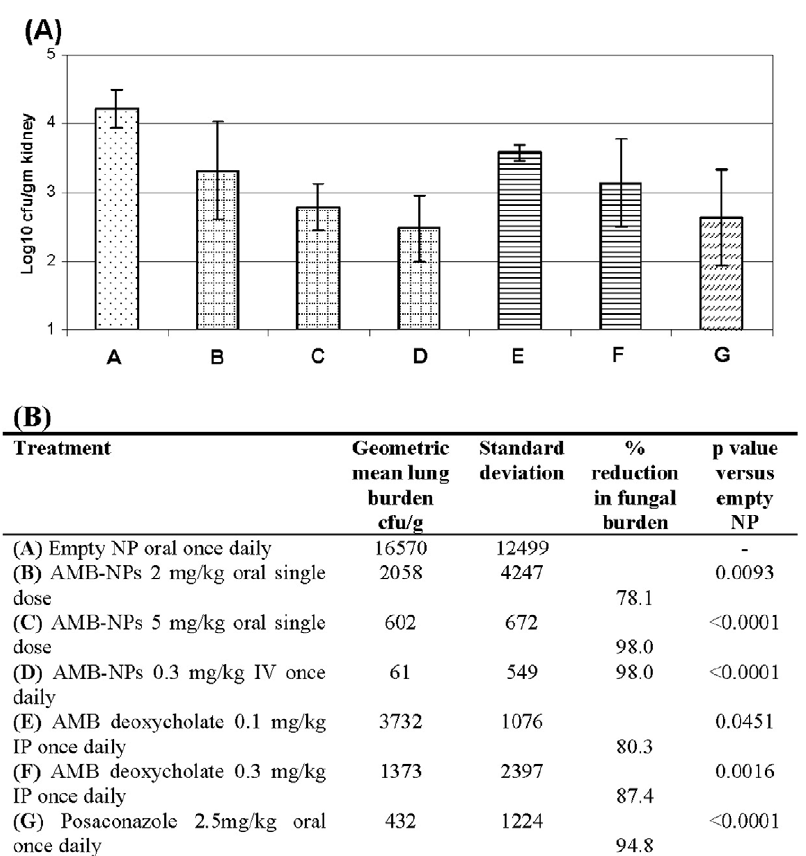
Figure 6. Kidney burden of mice with disseminated aspergillosis treated with AMB-NPs, AMB deoxycholate, and Posaconazole 101 hours post infection (Panel A). Geometric mean tissue burdens (and standard deviations) of mice with disseminated aspergillosis treated with AMB-NPs, AMB deoxycholate, and Posaconazole 101 hours post infection ( Panel B ). The p values are from a Kruskal Wallis test (Conover-Inman).